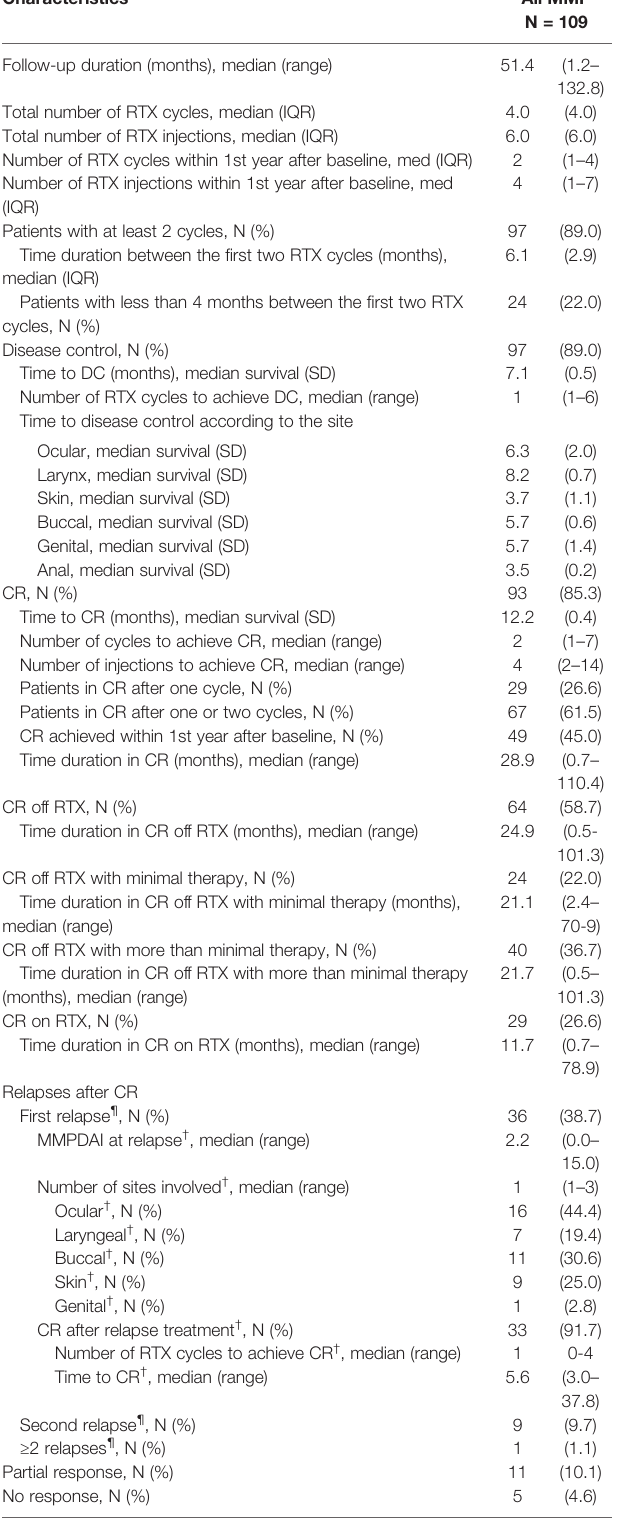
TABLE 3 | Outcome of rituximab therapy in patients with mucous membrane pemphigoid. Characteristics